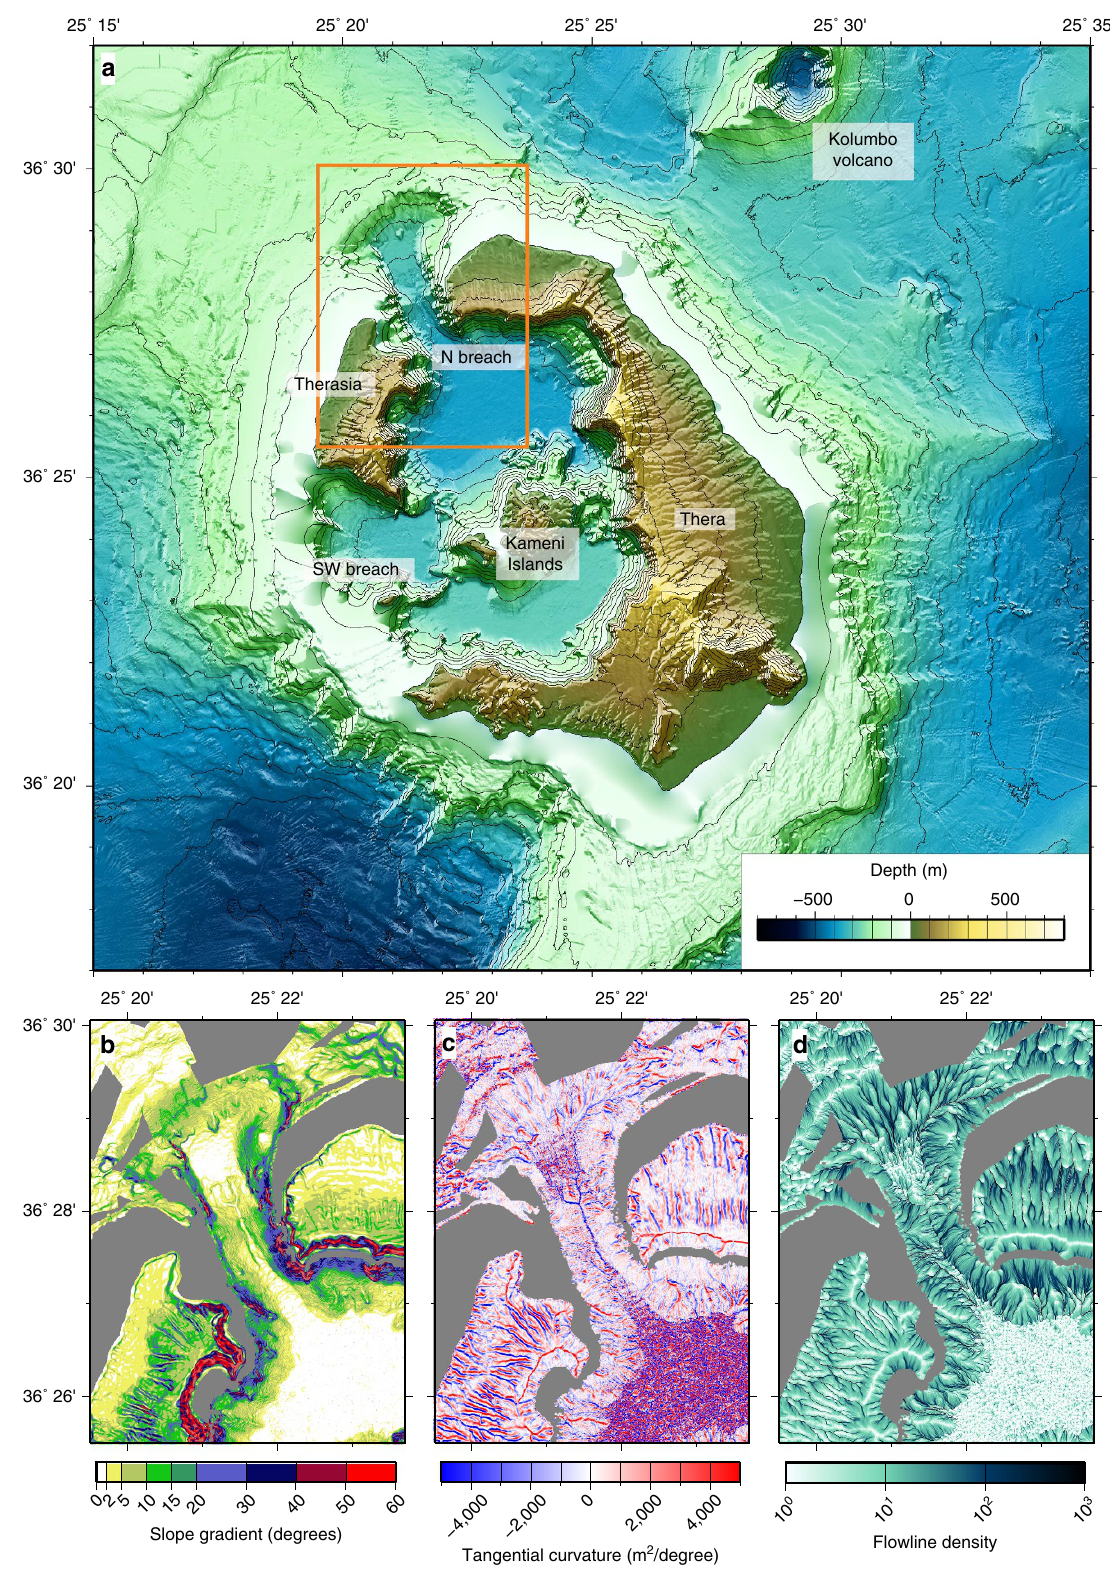
Figure 1 | Topographic features of the Santorini onshore-offshore volcanic field. ( a ) Combined topographic map of Santorini Volcano based on onshore and offshore data. Orange box outlines the area of the northwest strait, shown as ( b ) a slope gradient map, ( c ) a tangential curvature map and ( d ) a flowline density